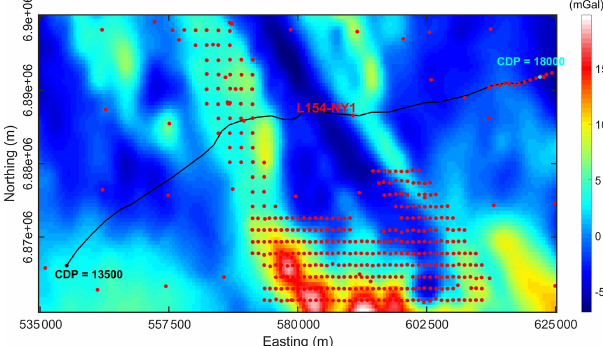
Figure 8. Interpolated gravity anomaly grid of Yamarna Terrane, from Geological Survey of Western Australia. Seismic traverse is shown as a solid black line within the region of interest (from CDP = 13500 to CDP = 18000). Red dots indicate the original lo- cations of gravity